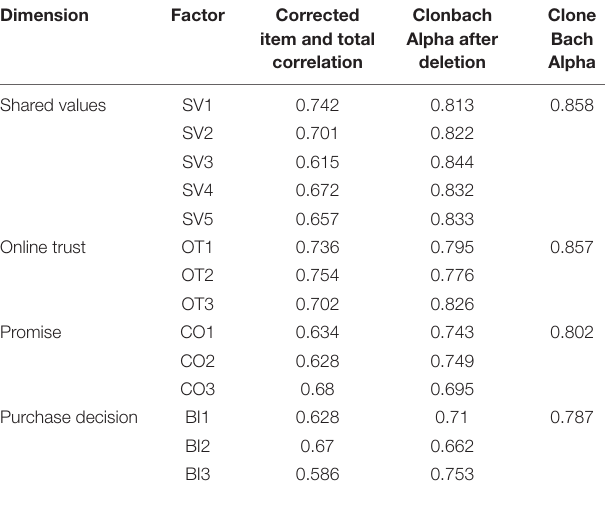
TABLE 1 | Reliability statistics and item total